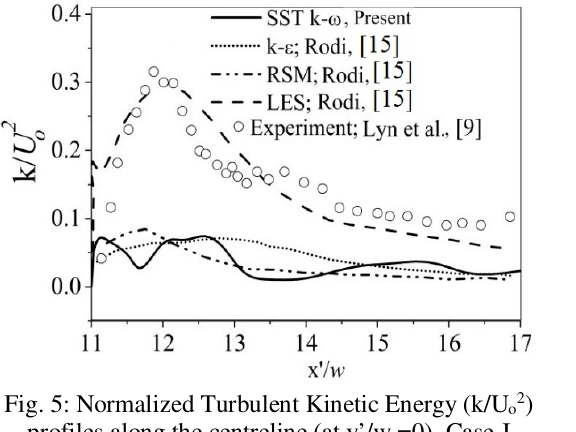
Fig. 5: Normalized Turbulent Kinetic Energy (k/U o2 ) profiles along the centreline (at y’/w =0),